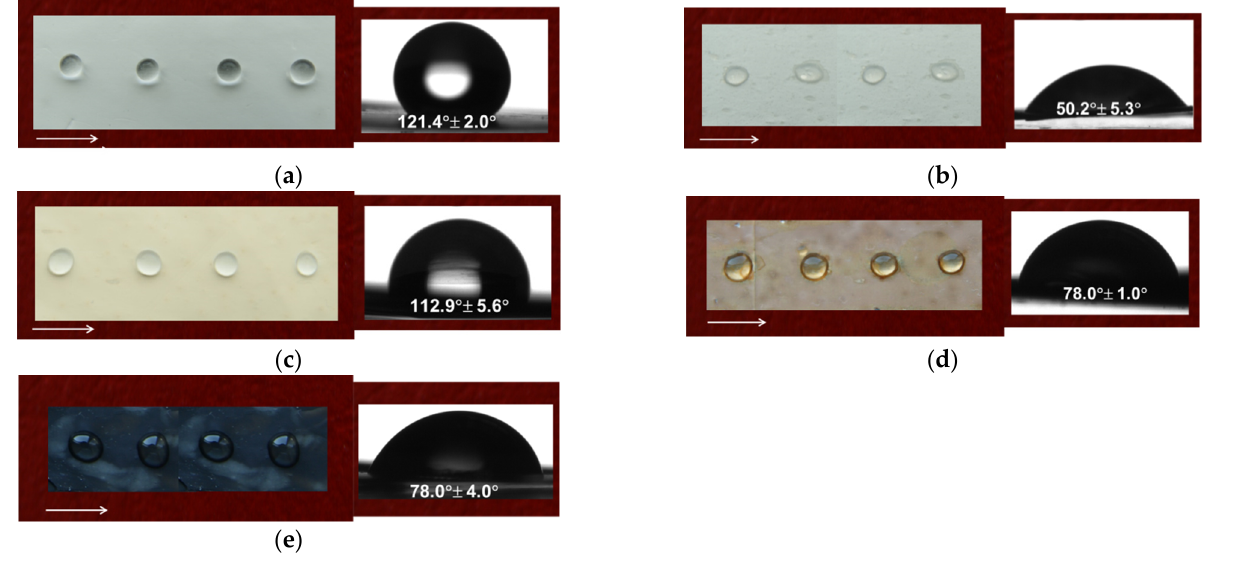
Figure 5. Digital images of water droplets (10 µL) deposited on the surfaces of fibrous mats from ( a ) PLA, ( b ) Ch/PLA, ( c ) Ch-8Q/PLA, ( d ) Cu 2+ complex of Ch-8Q/PLA and ( e ) Fe 3+ complex of Ch-8Q/PLA. The direction of the collector rotation is indicated by an arrow.